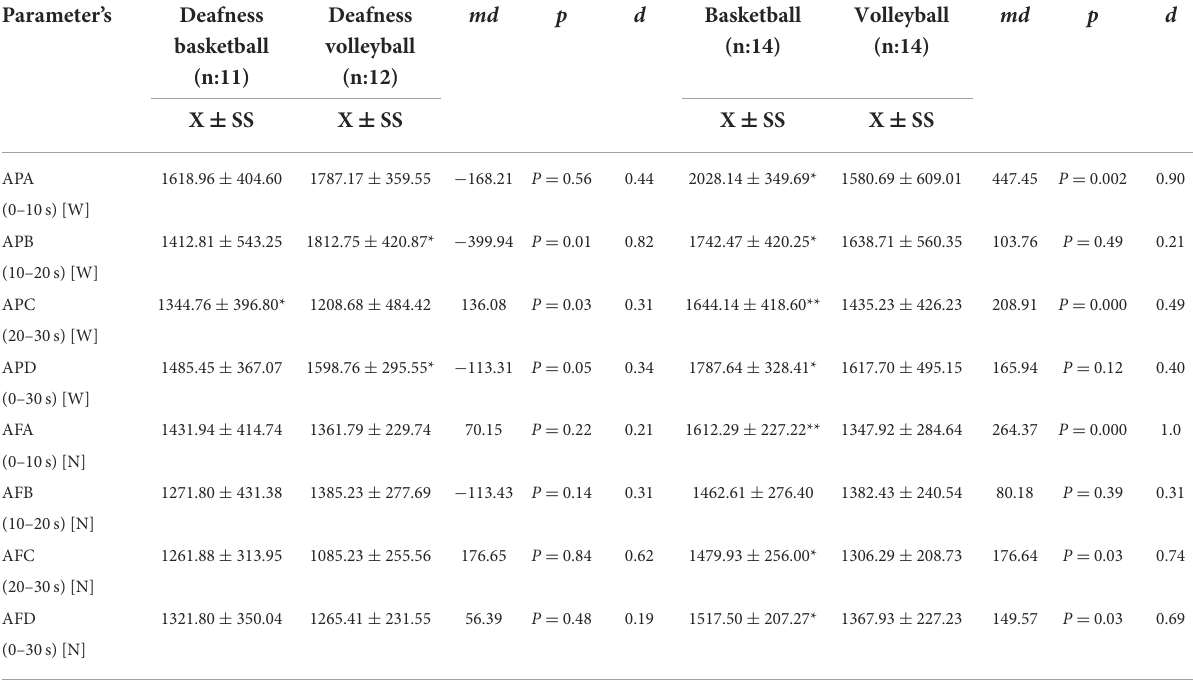
TABLE 6 Comparison of average power and force of deaf basketball/volleyball and non-deaf basketball/volleyball players. Parameter’s